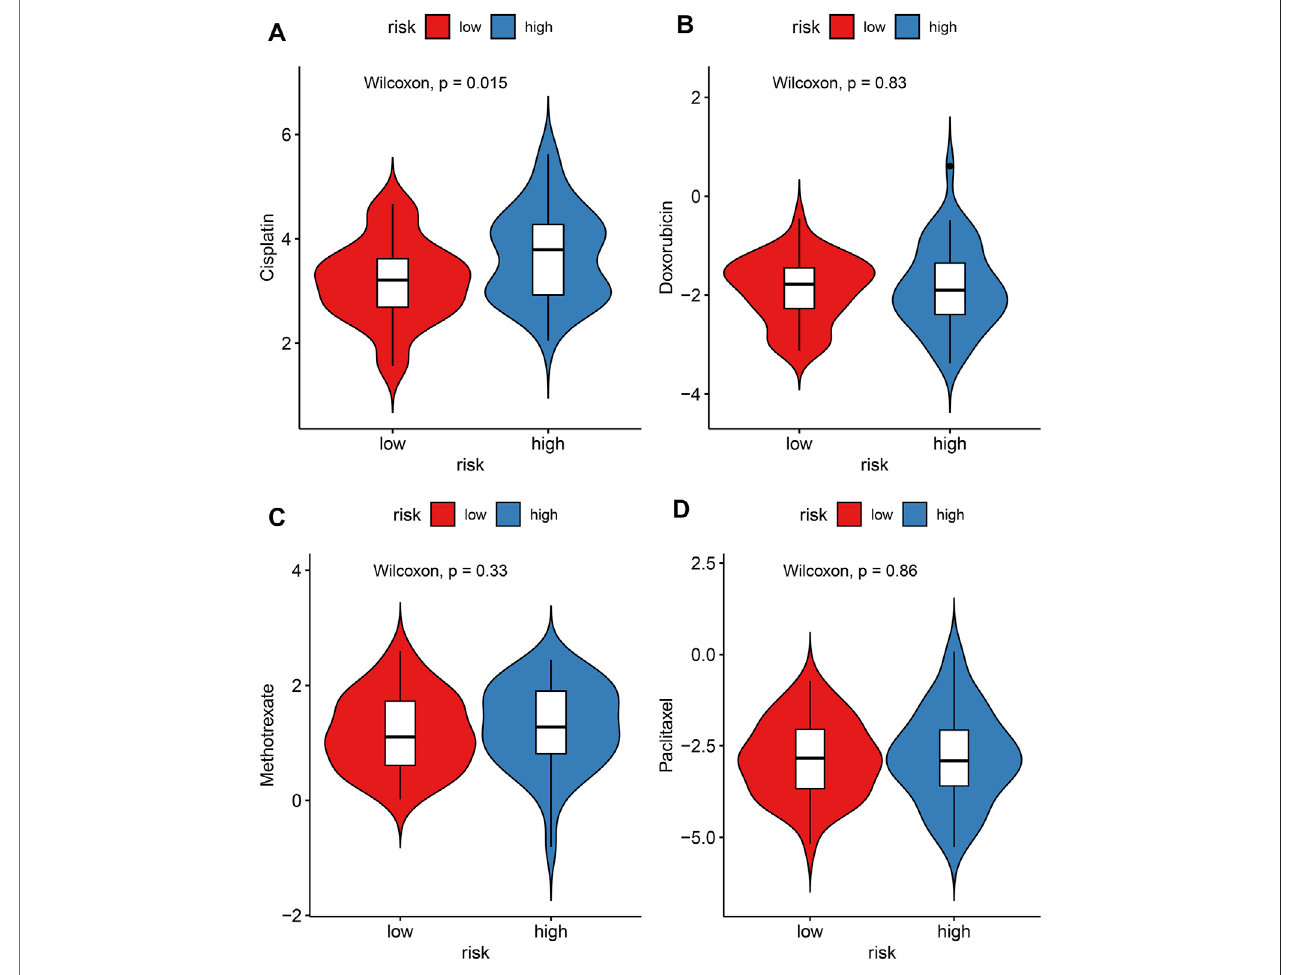
FIGURE 9 | Evaluation of the correlations between risk score and sensitivity to chemotherapy drugs in the TARGET cohort. (A) Cisplatin; (B) doxorubicin; (C) methotrexate; (D) paclitaxel. The differences were assessed by Wilcoxon tests.